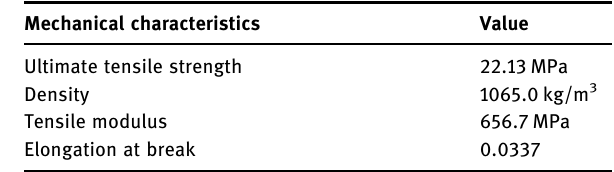
Table 2: CSM fi bre speci fi cations [ 23 ]